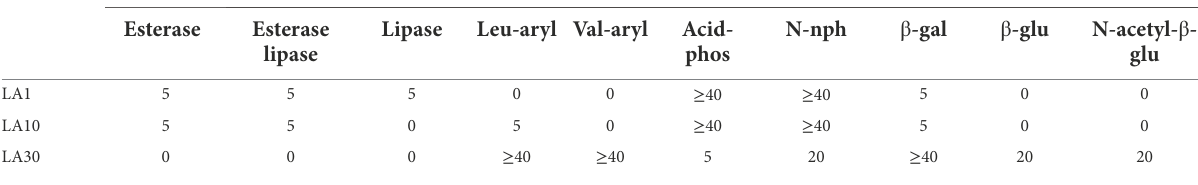
TABLE 2 Enzyme activities measured with the API-ZYM system of L. lactis subsp. lactis LA1, L. cremoris subsp. cremoris LA10, and L. plantarum LA30. Strain